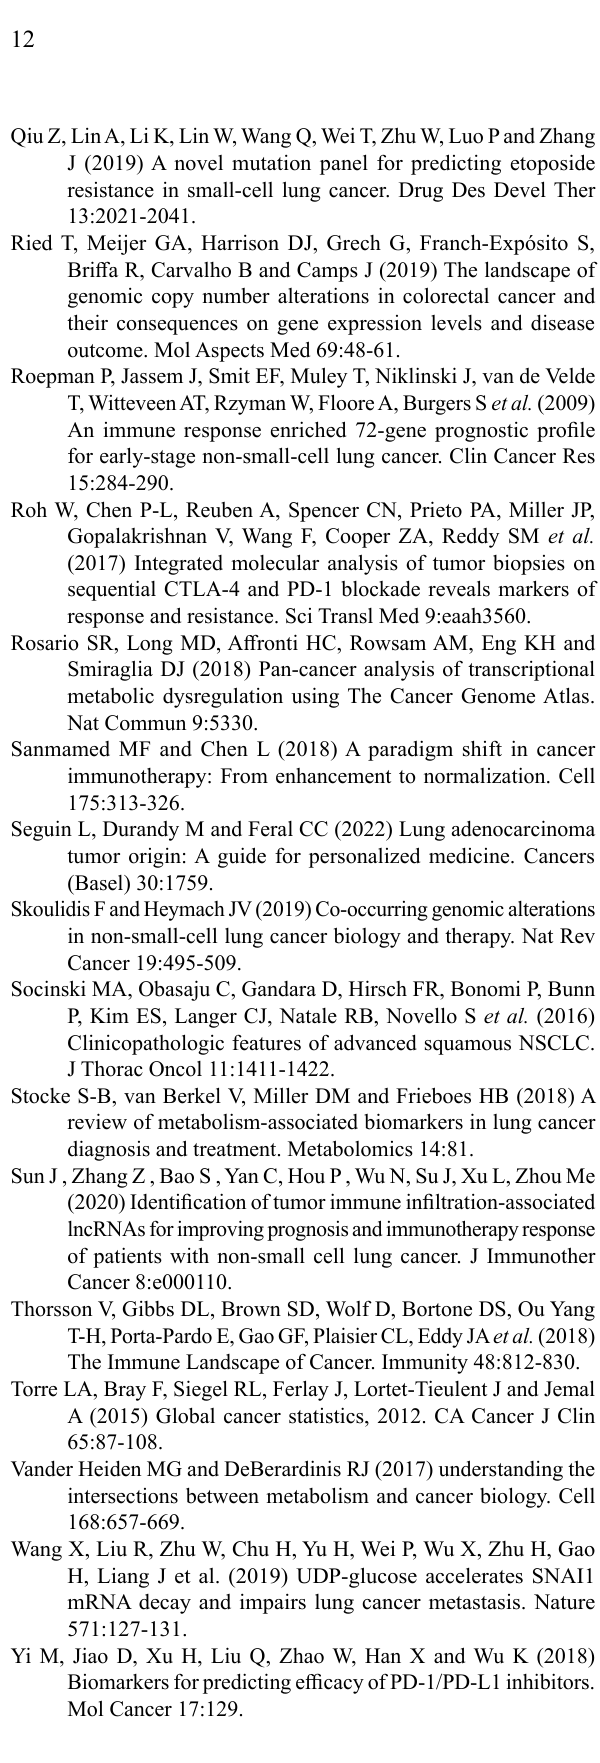
Figure S1 – A flow chart of the study. Figure S2 – PCA analysis for the GSEdat. Figure S3 – KM analysis between C2 and C3 in (A) GSEdat and (B) TCGA databases. Figure S4 – The biological functions for the 3 clusters. Figure S5 – Heatmap showing ssGSEA scores of the molecular subtypes of various metabolic processes. Figure S6 – Comparison of metabolic processes across the 3 clusters. Figure S7 – Comparison of scores of 19 biological features related tumorigenesis for the 3 clusters. Figure S8 – Immune infiltration scores of each molecular subtype. Figure S9 – Comparison of immune infiltration scores among the 3 clusters. Figure S10 – Mutation and survival of KRAS in LUAD patients. Figure S11 – The top 20 genes in the 3 clusters used to construct the